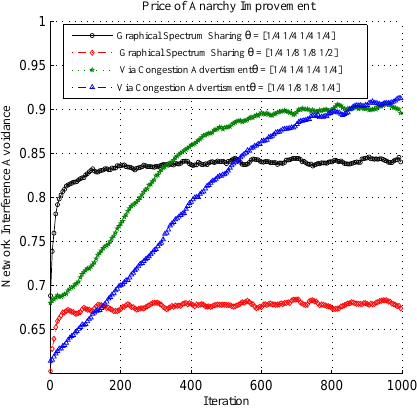
Figure 3. Price of Anarchy Improvement, B = 4 and the simulation has averaged over 100 realizations, best α for RLA learning for each case has selected to make the comparison independent of learning process, the network interference 1 avoidance is: 1 | V | P i ∈ V 1+ |I i |